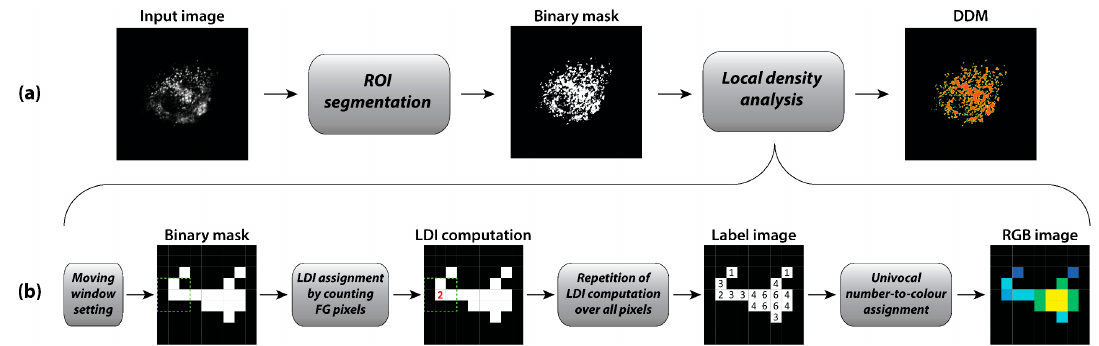
Figure 1. Flowchart of a DDM creation pipeline. ( a ) The acquired image is segmented in a binary mask. Then, the mask connectivity is explored by local density analysis to create the DDM in pseudo-colors. ( b ) Details of local density analysis: after setting the search (moving) window size, each foreground (FG) pixel of the binary mask is assigned a number representing the amount of FG pixels in its locality (i.e., LDI), this constituting the input to build the pseudo-color DDM.